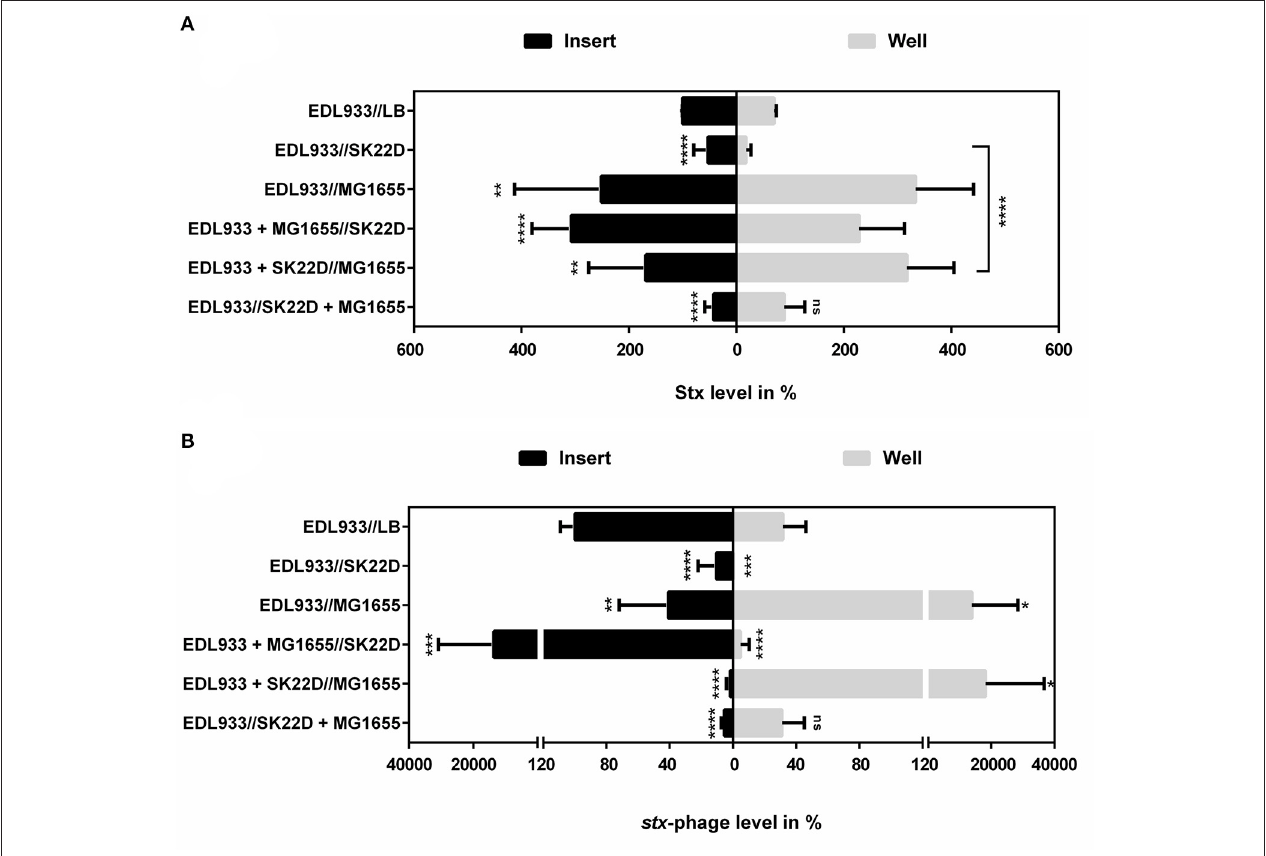
FIGURE 9 | Protection of MG1655 in the Transwell system. The STEC strain EDL933, the microcin negative EcN mutant SK22D and the K-12 strain MG1655 were separated by a transwell membrane with a pore size of 0.4 µ m in different combinations (1:10:10). After a 24 h, static incubation period the Stx level (A) and the phage titer (B) were detected in the sterile filtrate. The Stx level of the filtrate was determined with the Ridascreen ® Verotoxin Elisa. LB Medium was used as negative control. The phage titer was determined with the Phage Plaque Assay (PPA). The values were converted to percentage compared to the respective compartment control. ns, not significant, * p < 0.05, ** p < 0.01, *** p < 0.001, and **** p <